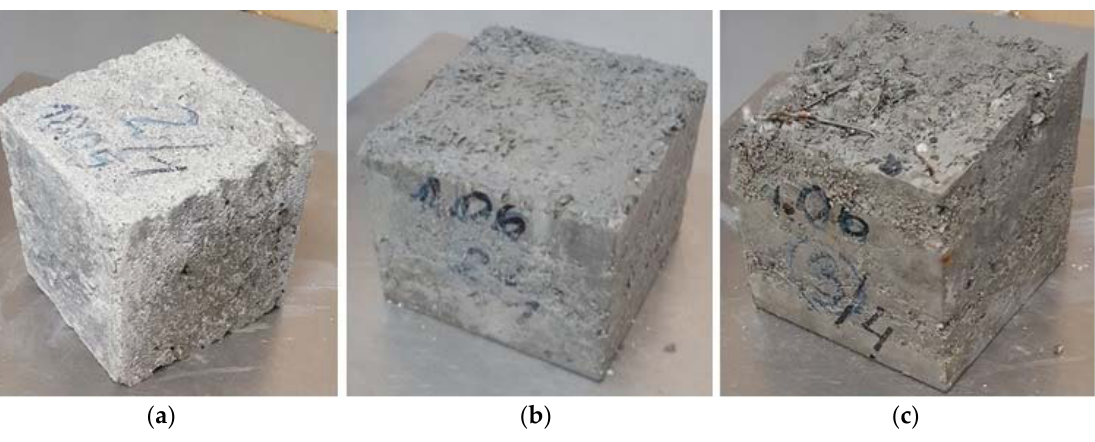
Figure 6. Condition of concrete following 50 F-T cycles: ( a ) C5P1b; ( b ) C15P0; ( c ) C15P50b50s. 3.3. Microstructure of Hybrid Fibres-Reinforced Self-Compacting Lightweight Concrete Figure 7 presents the microstructure and adhesion of cement paste to BF, SF and aggregates.